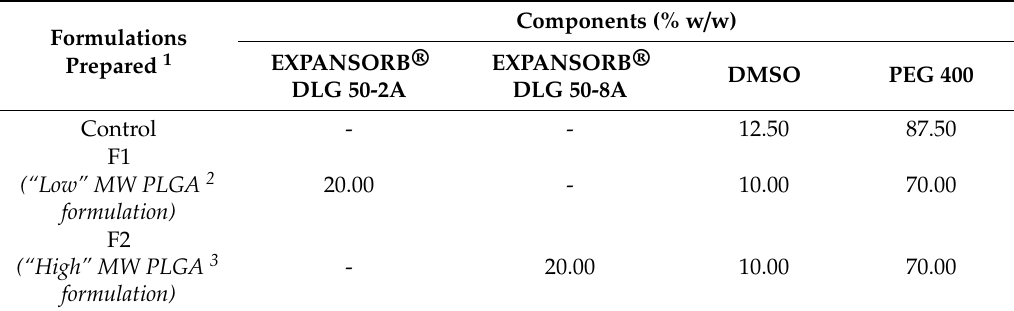
Table 1. Niacinamide formulations prepared with PLGA as the in situ gelling polymer.